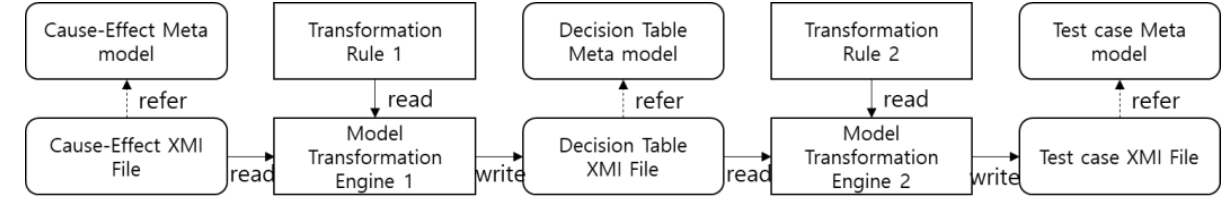
Decision Table created by the Decision Table Meta model. Likewise, the Decision Table is automatically converted into a Test case by Model Transformation Engine 2.